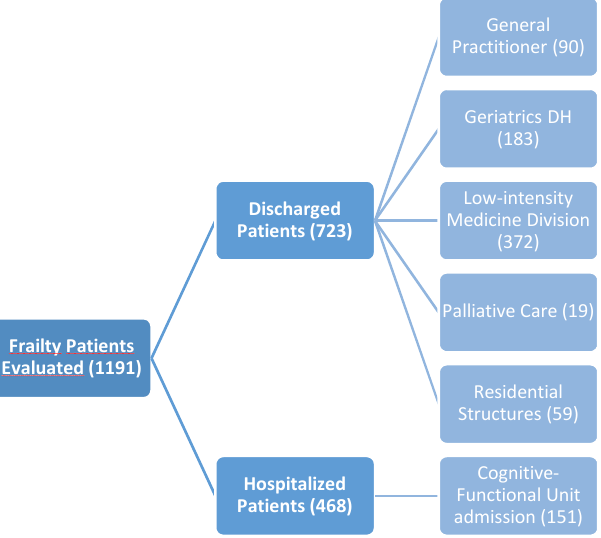
Figure 3. The Frailty Unit Experience.